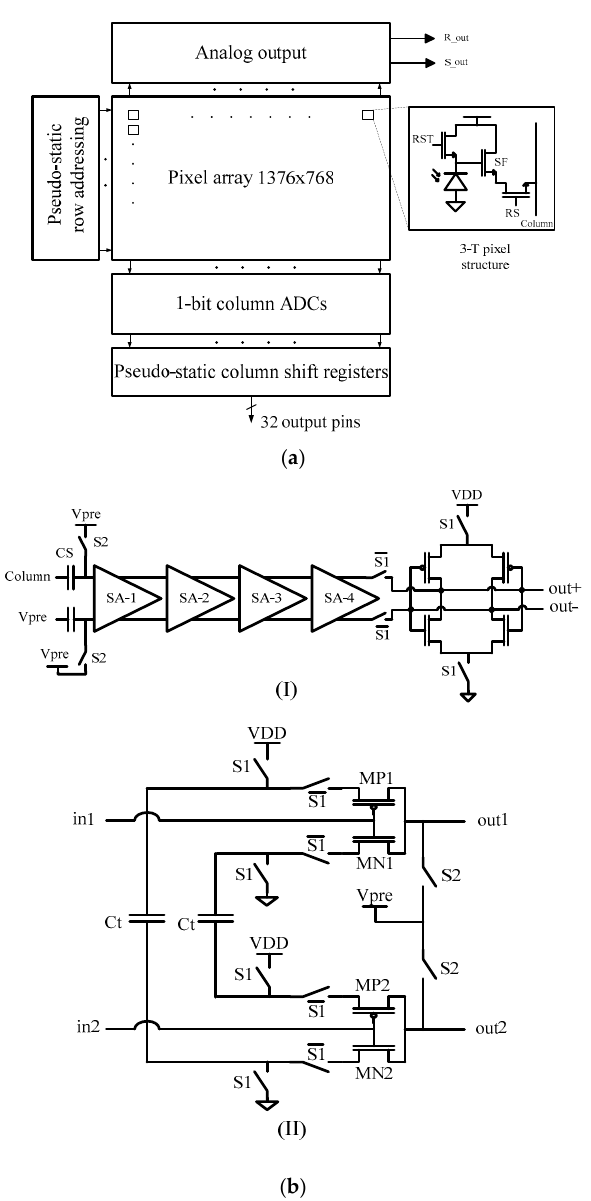
Figure 16. ( a ) Architecture of the 1Mpixel pathfinder image sensor; ( b ) (I) 1-b ADC based on a cascade of sense amplifiers and a single D-latch comparator; (II) Schematic of each sense amplifier that is implemented as a differential charge transfer amplifier. Table 2. Specifications of the 1 Mpixel binary image sensor.